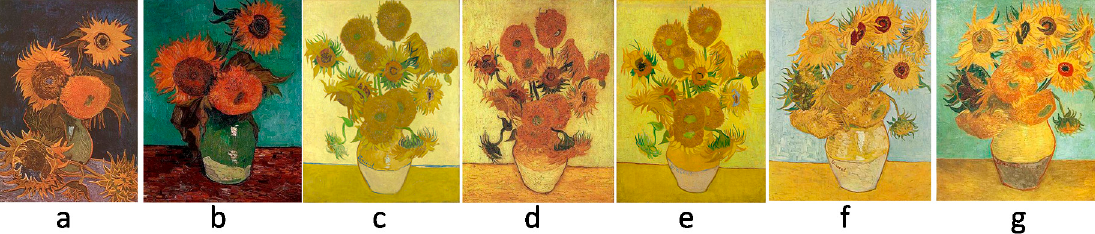
Figure 3. Series of 7 paintings of “Sunflowers” by Vincent Van Gogh: ( a ) “Vase with five sunflowers”, ( b ) “Vase with Three Sunflowers”, ( c ) “Vase with fifteen Sunflowers”(Arles, August 1888), ( d ) “Vase with fifteen Sunflowers (repetition)”, ( e ) “Vase with fifteen Sunflowers (repetition)”, ( f ) “Vase with twelve Sunflowers”, ( g ) “Vase with twelve Sunflowers(repetition)”.